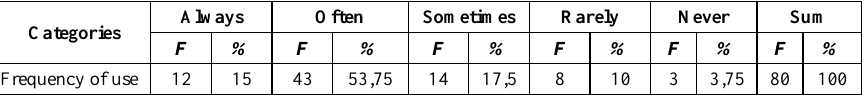
Table 3. Frequency of using mobile learning applications by students